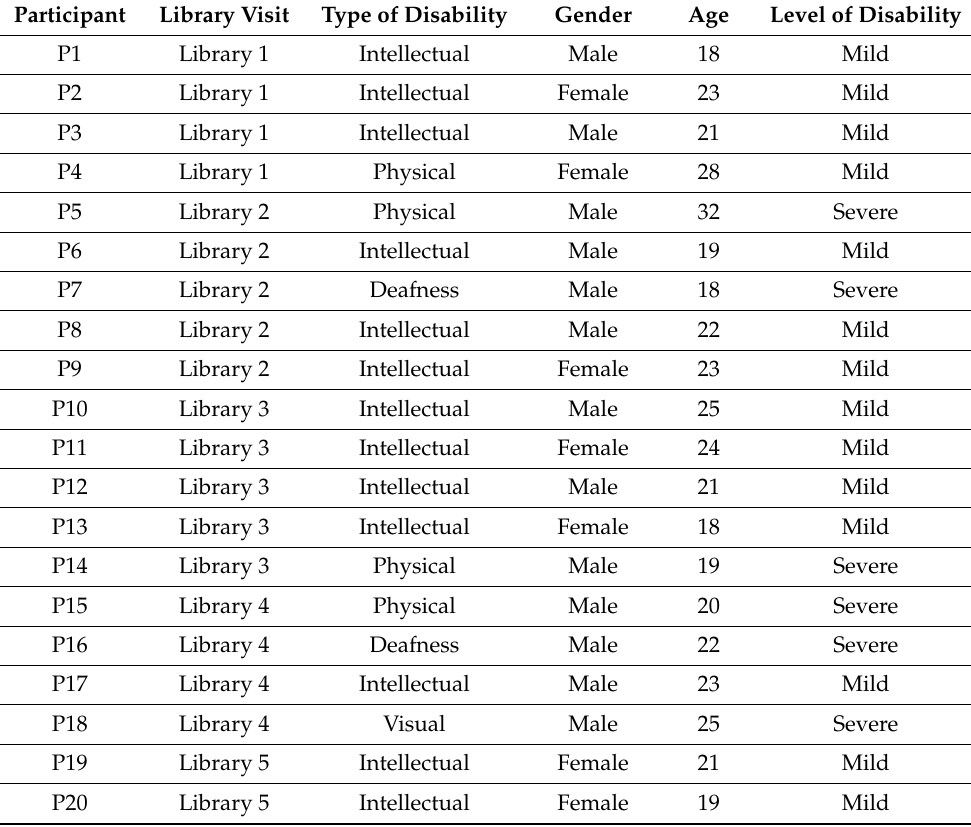
Table 1. Sample of participants with